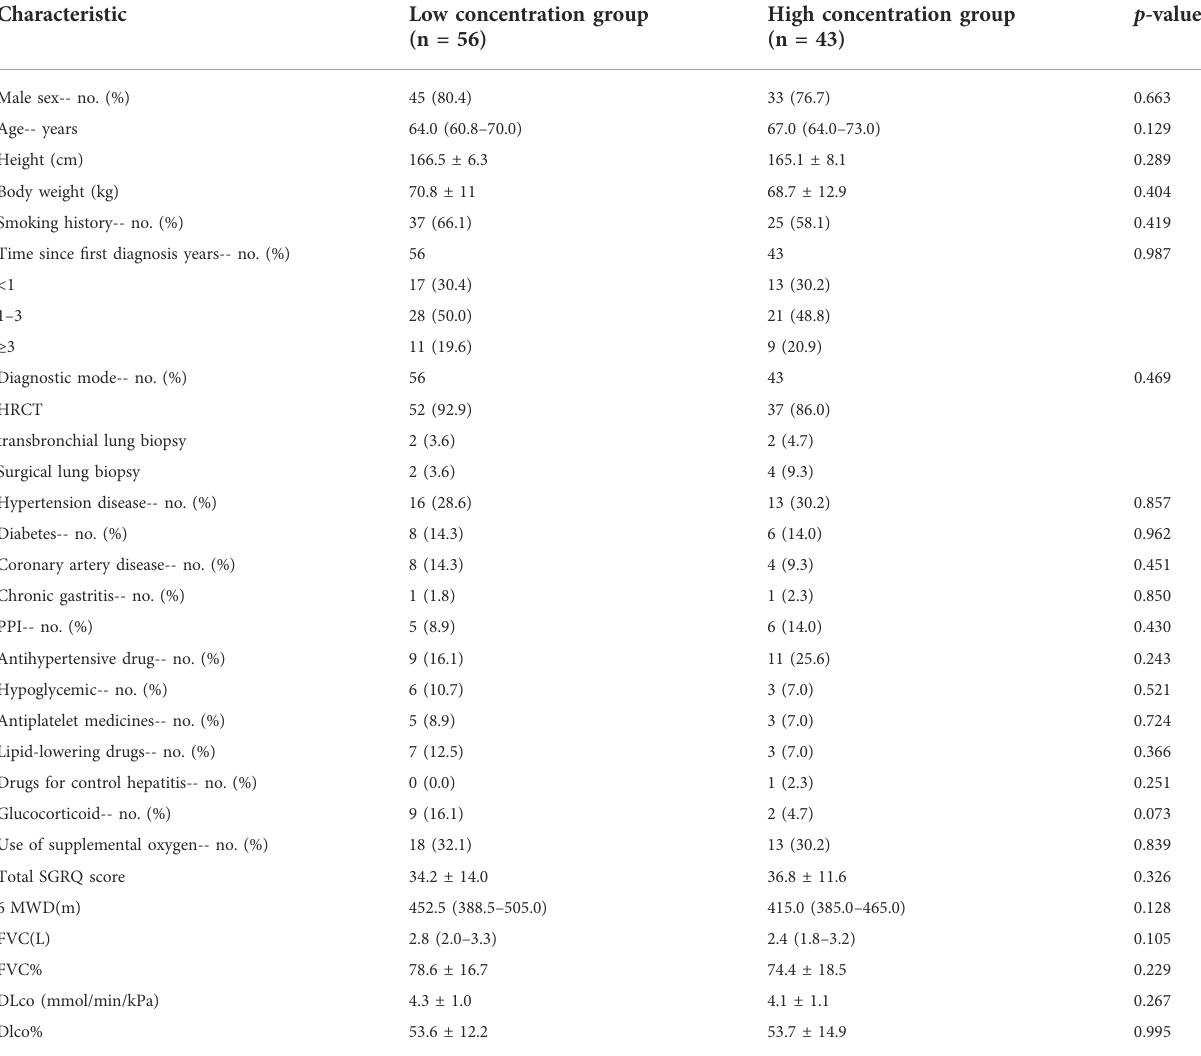
TABLE 1 Characteristics of the patients at baseline.